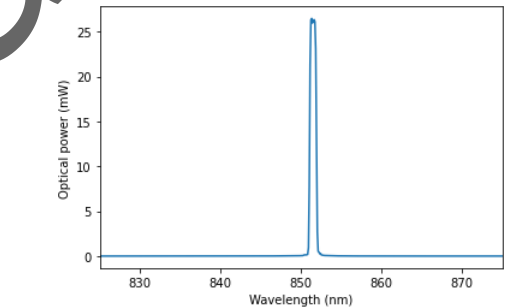
Fig 1. Emission spectrum of the laser.